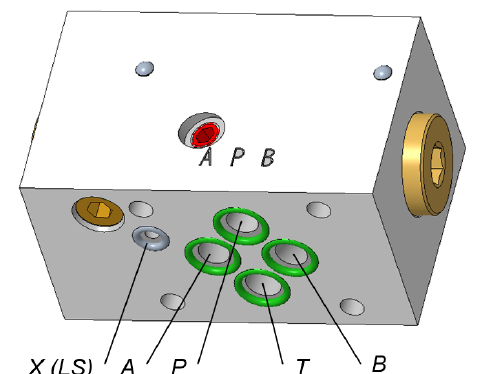
Figure 2. 3D model of the differential valve: 1—valve body, P , A , B , T , LS —connecting ports.